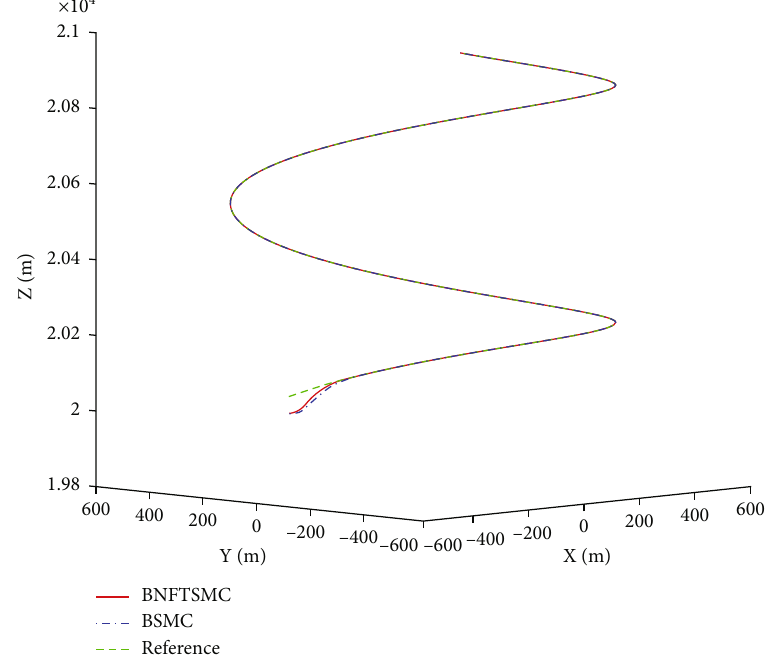
Figure 4: Trajectory tracking results in three-dimensional space.